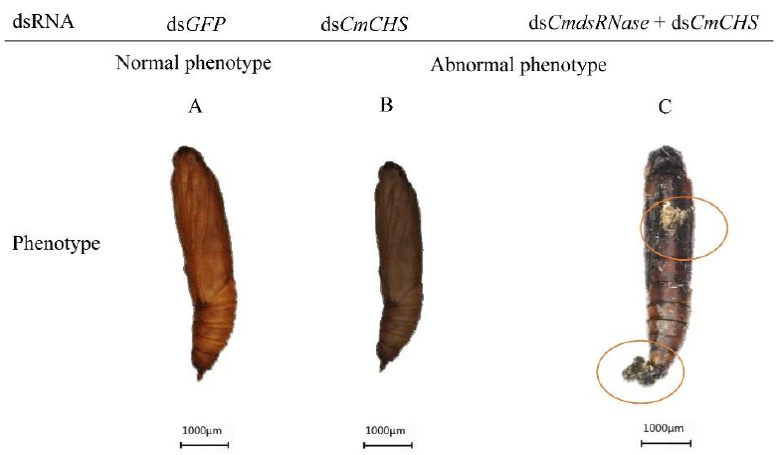
Figure 11. Abnormal morphology of C. medinalis larvae after dsRNA injection. ( A ) Phenotypes of larvae after ds GFP injection. ( B , C ) ds CmCHS -injected larvae. ( D – F ) Larvae injected with ds CmdsR- Nase + ds CmCHS . Red circles indicate the phenotypic changes in the larvae. Each scale bar represents 1000 μ m.